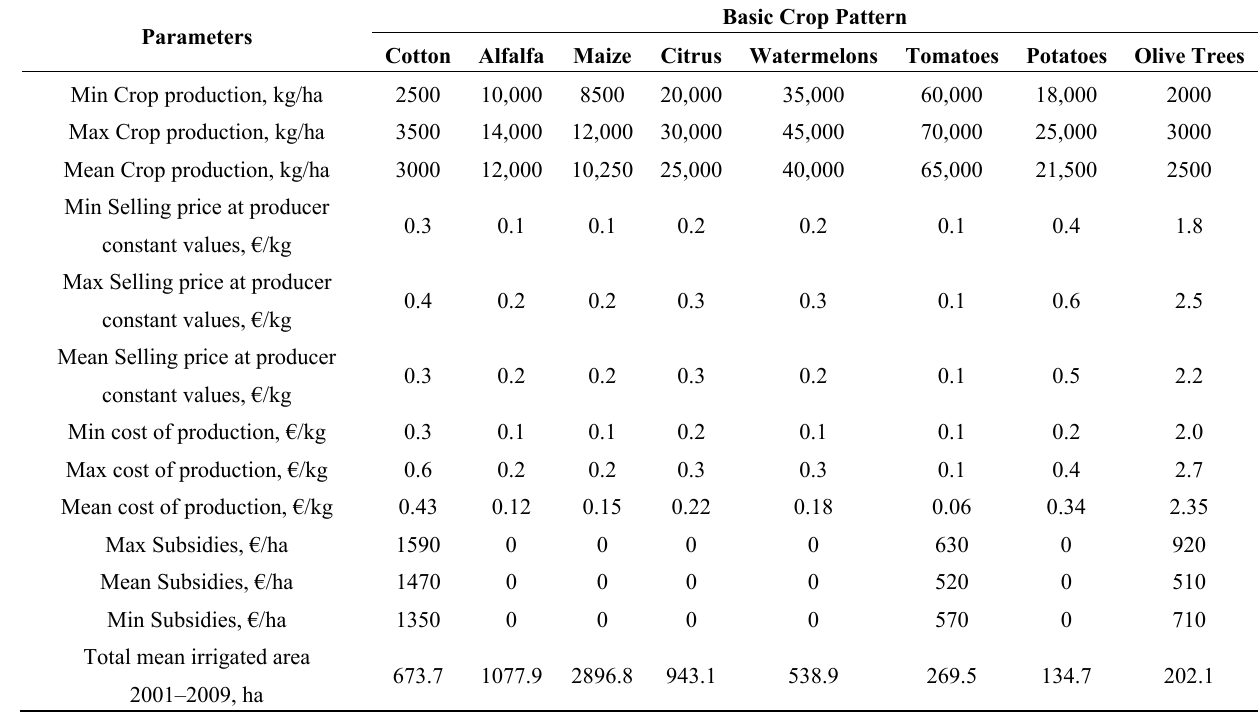
Table 5. Technical, economic and social parameters for the crop pattern of the Flokas irrigation